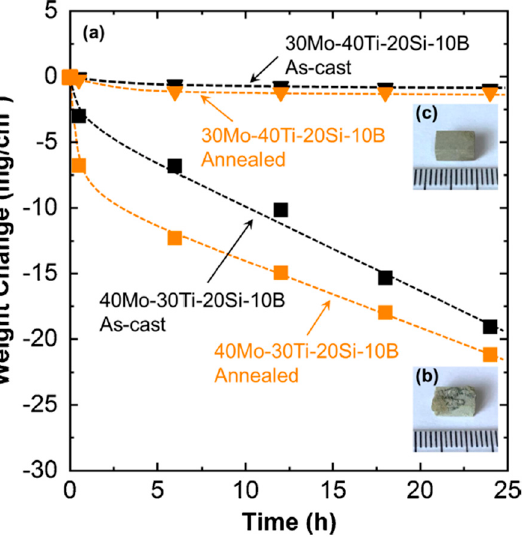
Figure 15. ( a ) Specific weight change of Mo–30Ti–20Si–10B and Mo–40Ti–20Si–10B (at.%) alloys oxidized at 800 °C. Black points refer to the data of as-cast alloys and orange ones refer to annealed alloys. ( b , c ) are the respective micrographs of the annealed specimens after oxidization at 800 °C for 24 h [48].